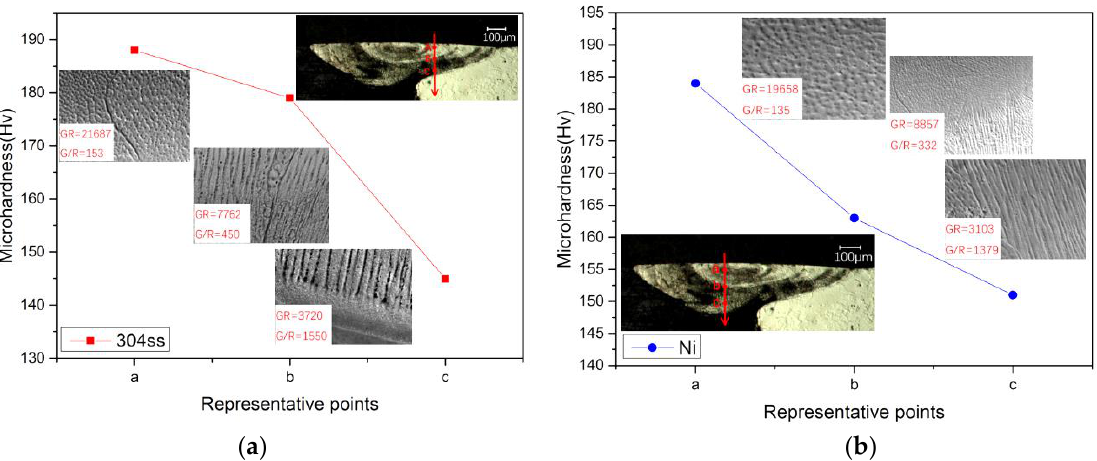
Figure 16. Microhardness and microstructure of representative points at the heat input of 40 J/mm. ( a ) 304ss side. ( b ) Ni side.